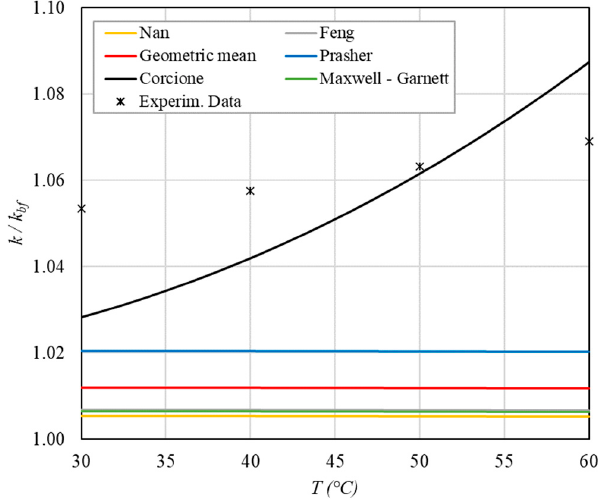
Figure 9. Increase in thermal conductivity versus temperature for φ = 0.22%.